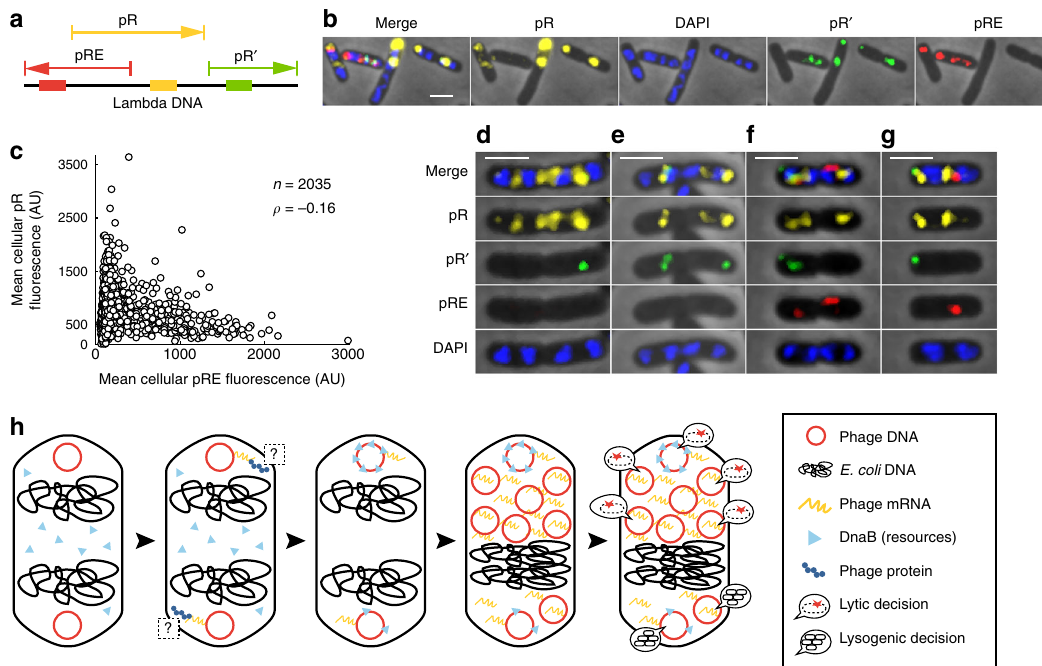
Fig. 5 Individual phage decision-making occurs in separated subcellular locations. a Colored arrows represent the transcripts targeted by FISH. The arrow direction corresponds to the transcription direction. The colored line segments on the black line mark the approximate locations of the FISH probes relative to the transcripts. b Decision-making transcripts localize to subcellular locations. Representative infected cells at 15 min post-infection with cells DAPI-stained. Representative cells chosen from four independent infection experiments. All scale bars in this fi gure are 2 μ m. c Average pRE FISH signal is plotted against pR signal (Pearson ’ s ρ in plot, p value <0.001). d – g Phages make different decisions in separate subcellular locations. pR transcripts, separated by DAPI clusters, occupy separate areas. Of 2035 cells, 645 have pRE foci. Of 2035 cells, 439 have pR ʹ foci. In all, 504/2035 cells have pRE without pR ʹ foci. Of 2035, 298 cells have pR ʹ without pRE foci. d – e Representative cells showing lytic decisions in a subset of different locations